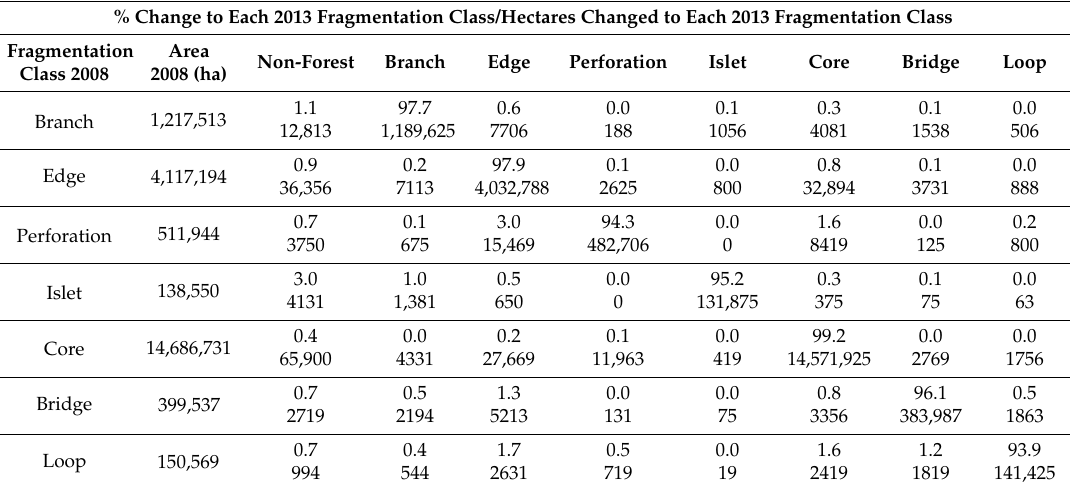
Table C2. Fragmentation classes transition matrices for temperate forests in the 2008–2013 period without differentiating between internal and external